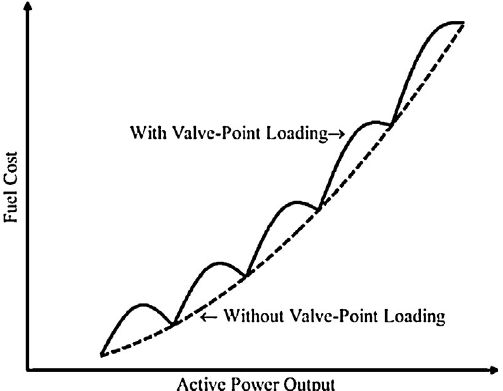
Figure 3. Valve-point loading effect of electrical energy generator